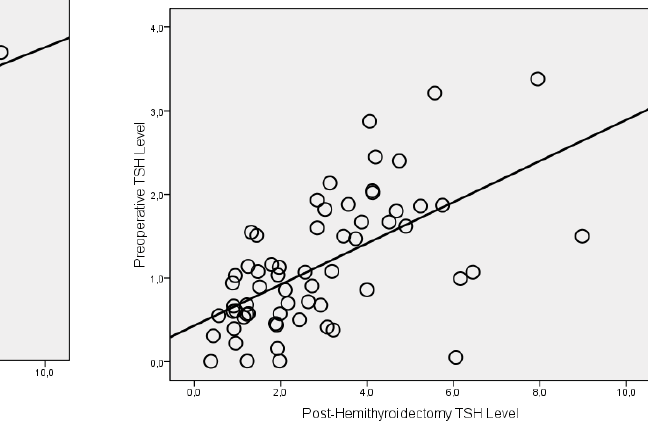
Figure 1b. Scatter diagram of the preoperative thyroid stimulating hormone (TSH) level ( mU/l ) versus the post- hemithyroidectomy TSH level (2 months after the